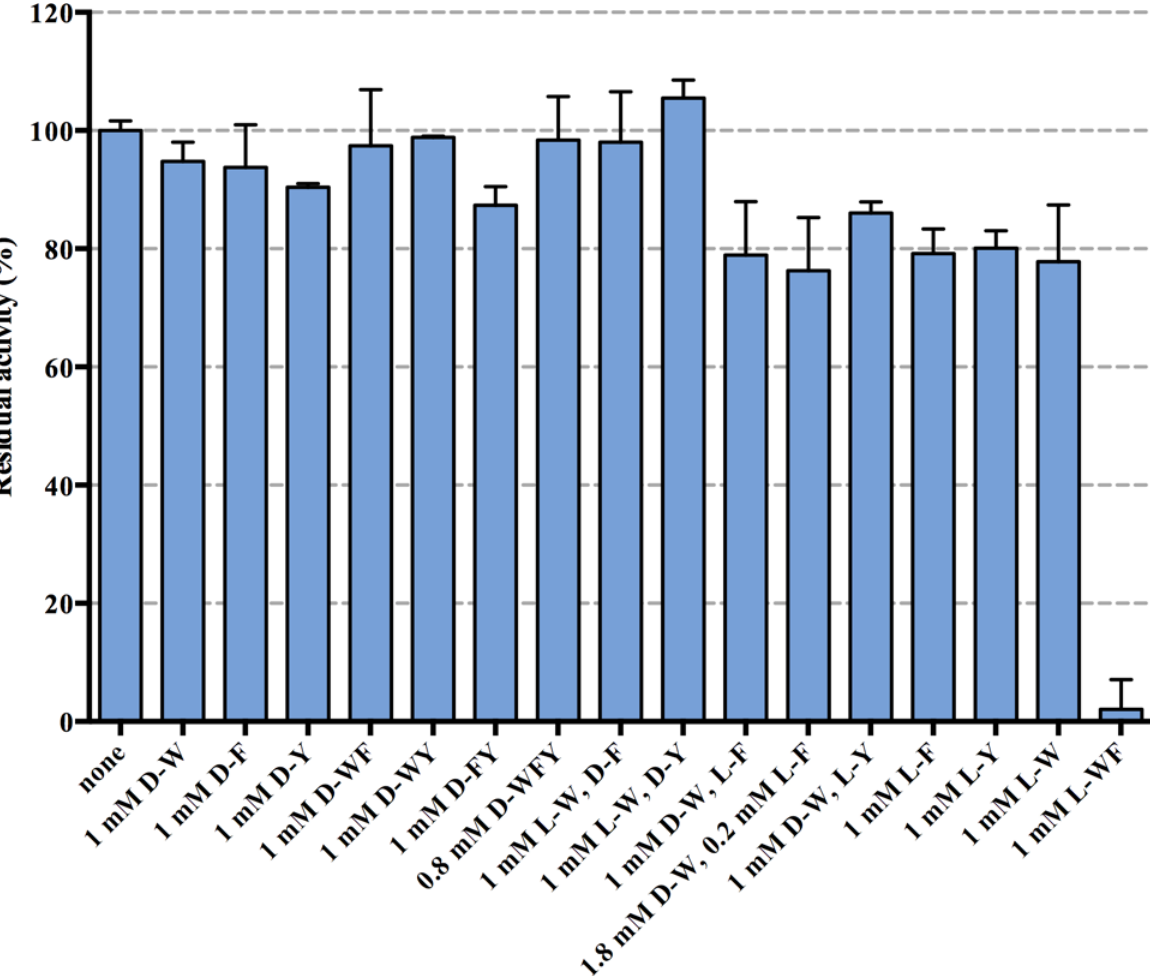
Fig 2. Effect of aromatic D -amino acids and combinations of D - and L -amino acids on Mtu DAH7PS activity. Error bars represent standard deviation of replicates, all activities are normalized to the activity obtained without addition of any aromatic amino acids. The triple combination of D -WFY was conducted at 0.8 mM concentration each to avoid non-linear effects at high absorbance in the photometric assay. The concentration of both PEP and E4P was 150 μ M. W = tryptophan, F = phenylalanine, Y = tyrosine.